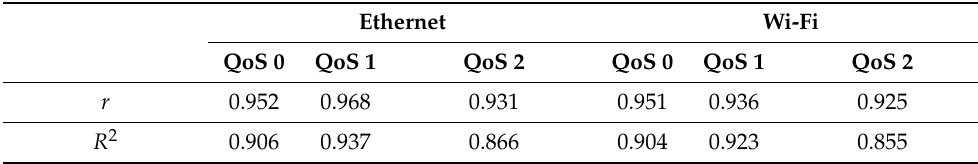
Table 3. Correlation between payload and delay for each QoS level.